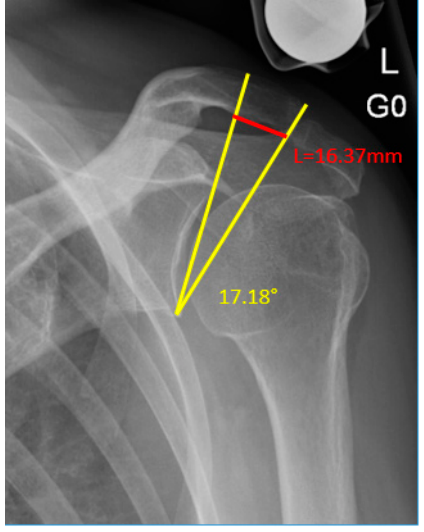
Figure 3. Left shoulder anteroposterior radiograph illustrating the acromioclavicular offset angle (ACOA, in yellow) and the AC offset (in red).